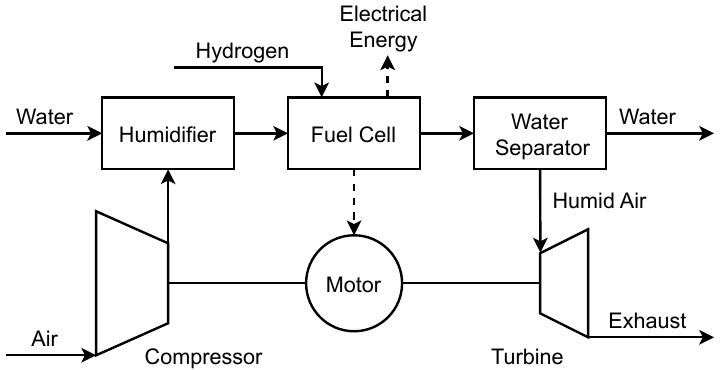
Figure 1. Electrically turbocharged cathode system for a